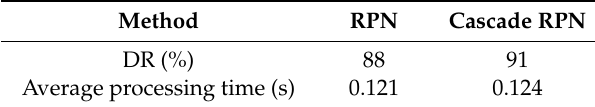
Table 6. Results of different region proposal methods.